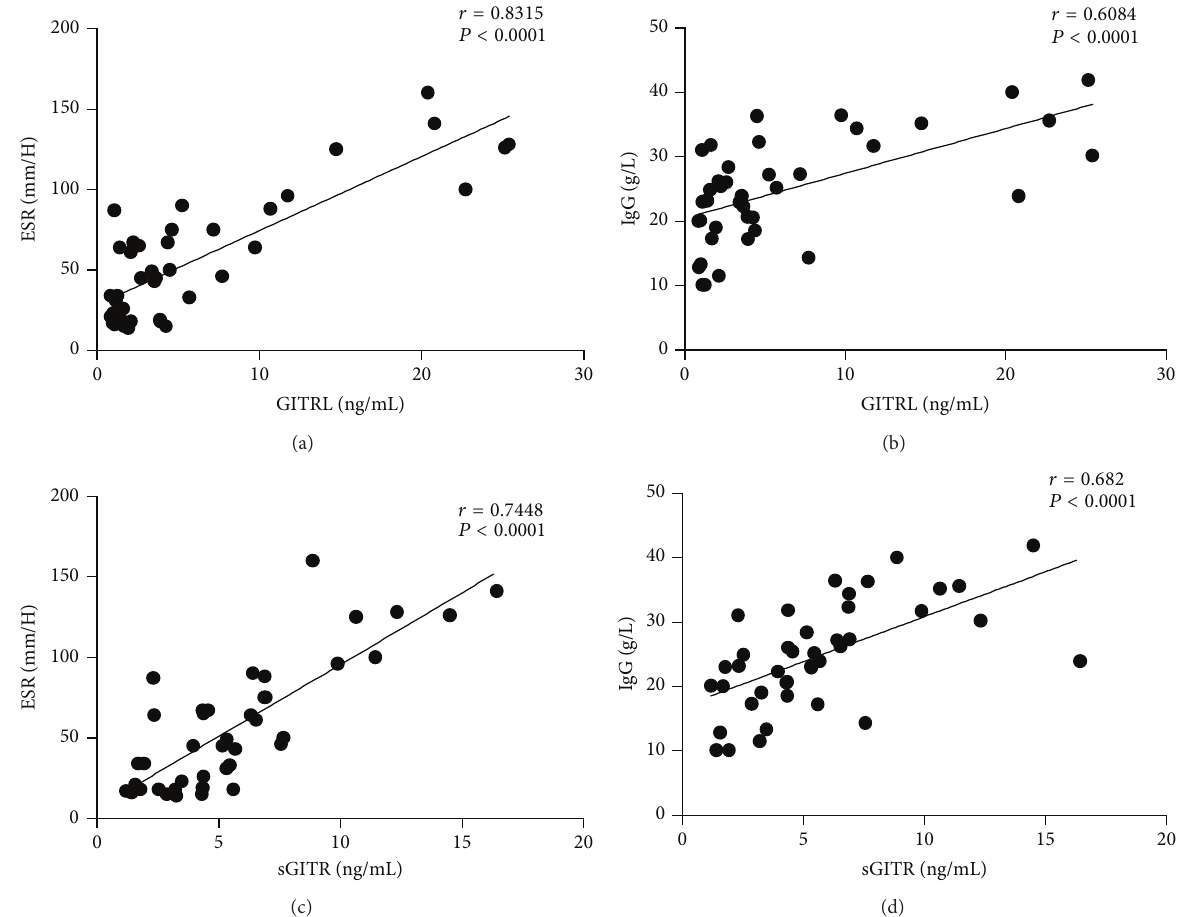
Figure 4: Correlation of serum GITRL and sGITR levels with laboratory values. (a), (b) Positive correlation was observed between serum GITRL levels and ESR, IgG. (c), (d) Positive correlation was also seen between serum sGITR levels and ESR, IgG. ESR: erythrocyte sedimentation rate; IgG: immunoglobulin